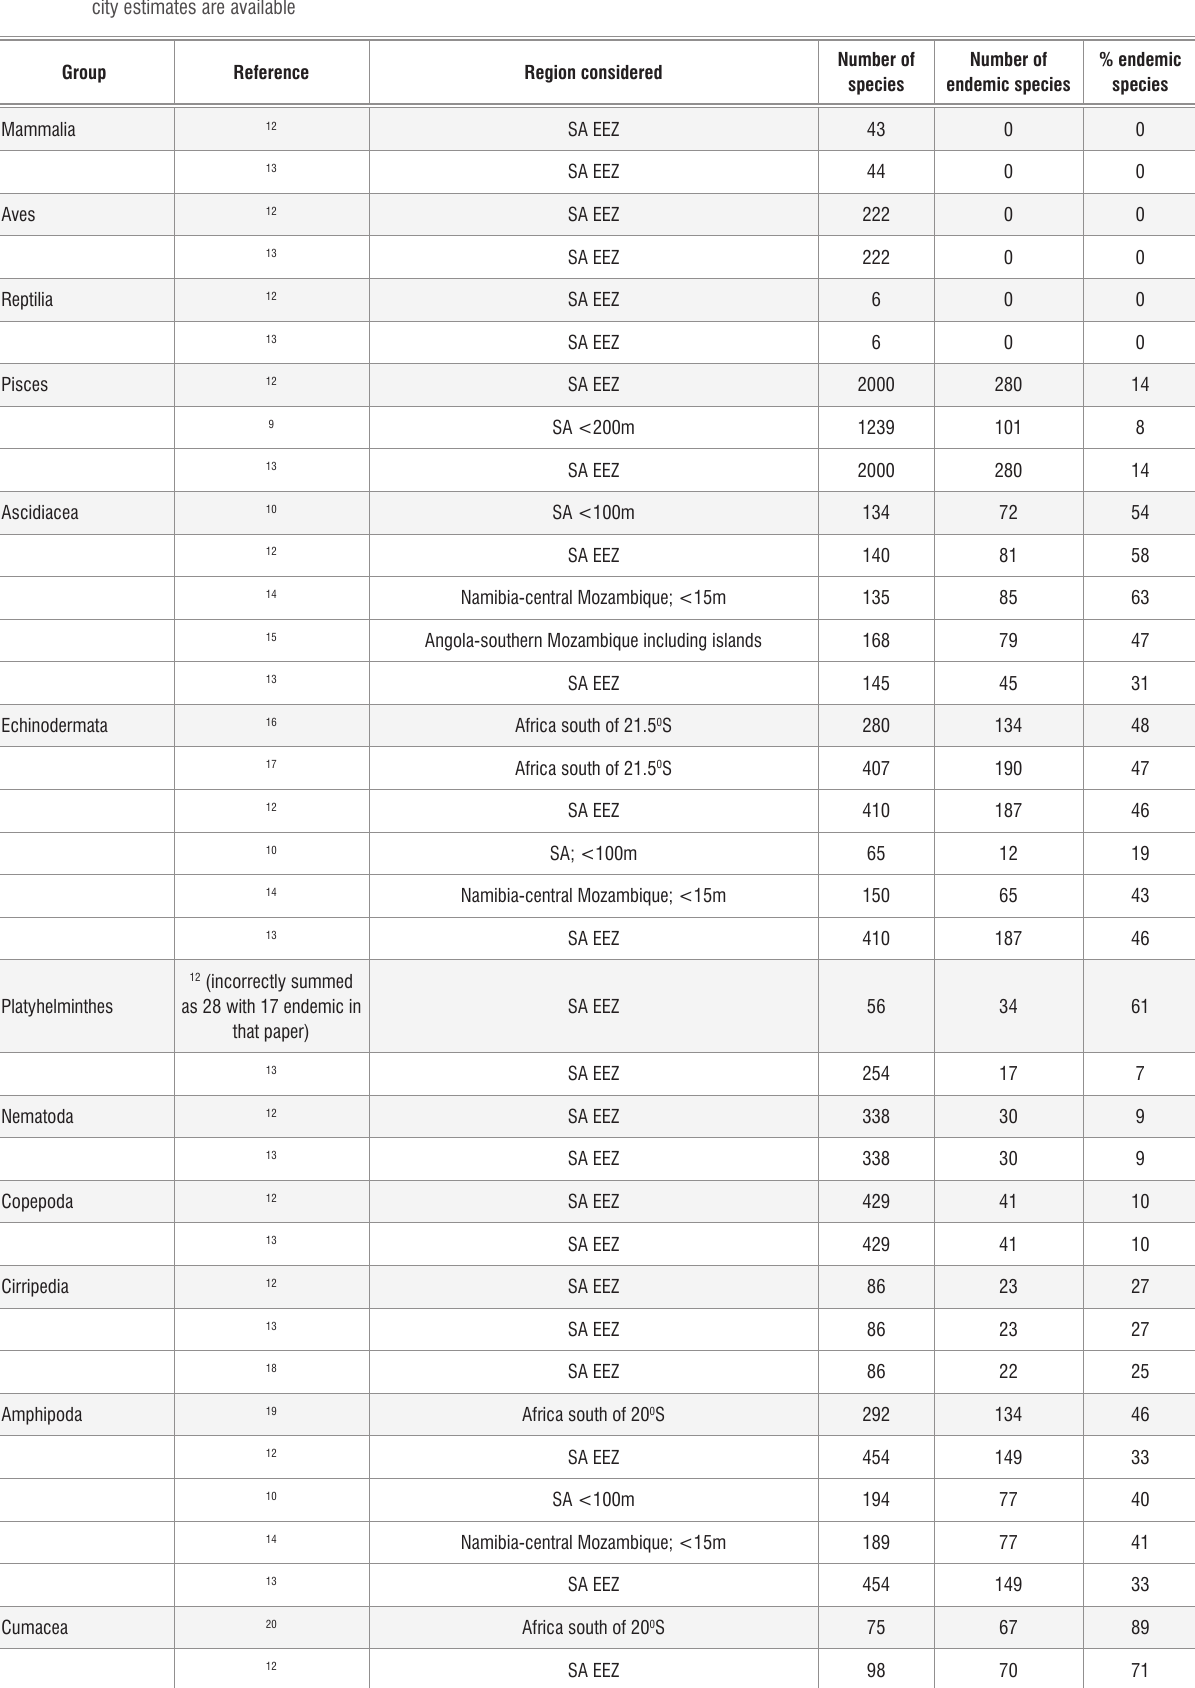
Table 1: Measures of endemicity for selected marine taxa from southern Africa. Taxa selected are ‘major’ grouping for which at least two separate endemi- city estimates are available Group Reference Region considered